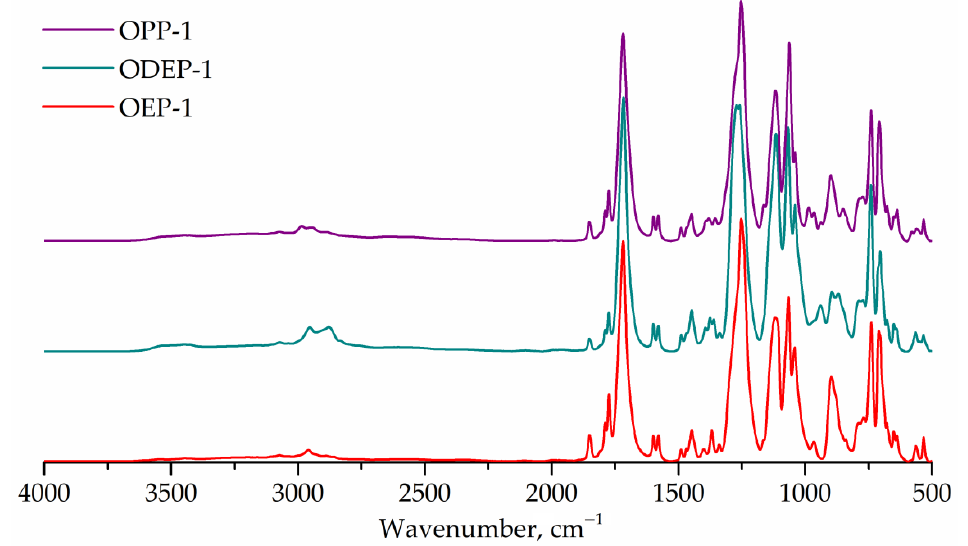
Figure 4. FTIR spectra of OEP-1, ODEP-1, and OPP-1 samples. GPC curves for OEP-1, ODEP-1, and OPP-1 samples are shown in Figure 5. Figure 5. GPC curves of OEP-1, ODEP-1, and OPP-1 samples. The GPC curve of sample OEP-1 has a peak (257 g/mol) with a shoulder (195 g/mol) corresponding to phthalic acid ethylene glycol diester and monoester. The adjacent strong peak (337 g/mol) seems to correspond to phthalic acid diethylene glycol diester, which is known to form in polycondensation processes with ethylene glycol [7]. Other peaks (504, 727, 945, and 1198 g/mol) correspond to oligomers. The GPC curve for the diethylene glycol-containing ODEP-1 sample has a peak (268 g/mol) with a shoulder (315 g/mol) corresponding to phthalic acid diethylene glycol mo- noester and diester, and peaks of oligomers (474, 667, 882, and 1089 g/mol). The OPP-1 sample curve exhibits the peak of phthalic acid 1,2-propylene glycol mo- noester (236 g/mol) with a shoulder of diester (263 g/mol) as well as peaks of oligomers (426, 594, 765, and 933 g/mol).